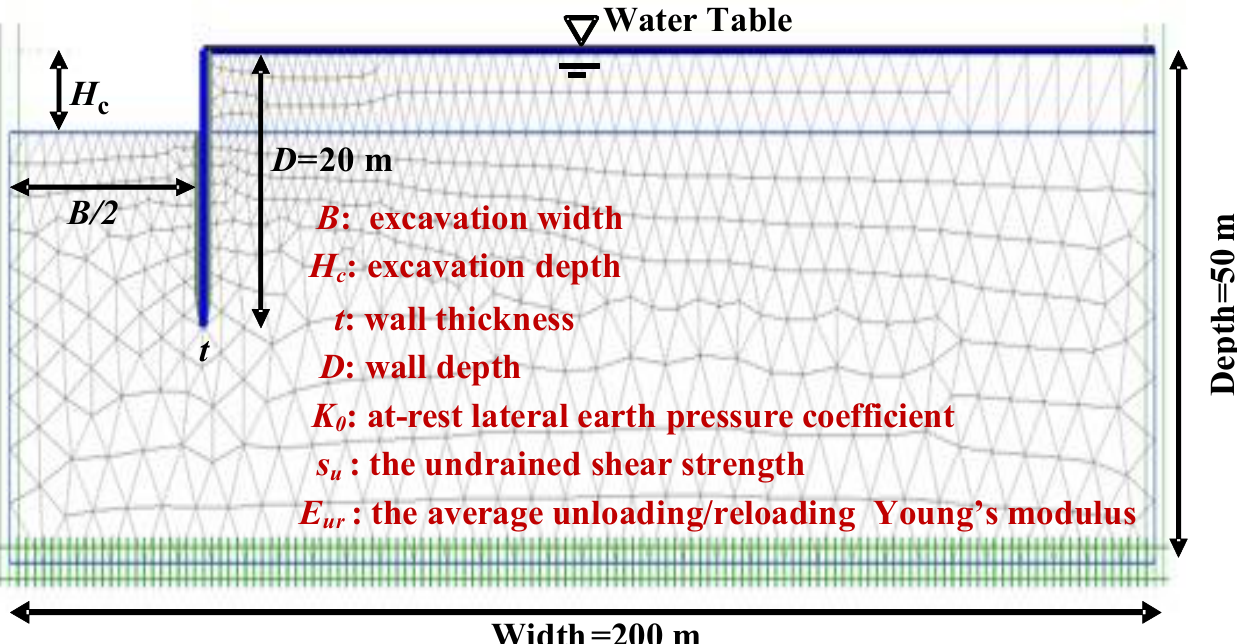
Figure 1. Finite element model in Plaxis.